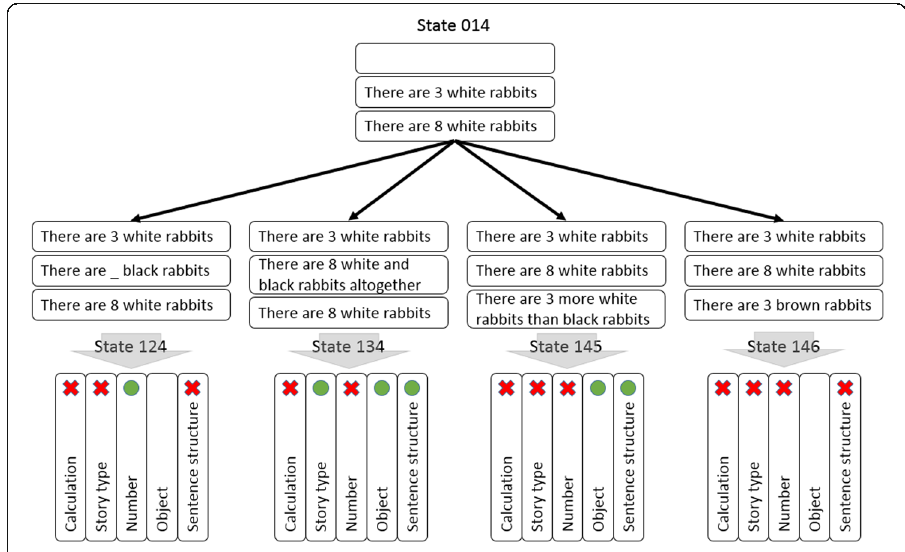
Fig. 5 Derivative states of state 014 and the constraint satisfaction in assignment